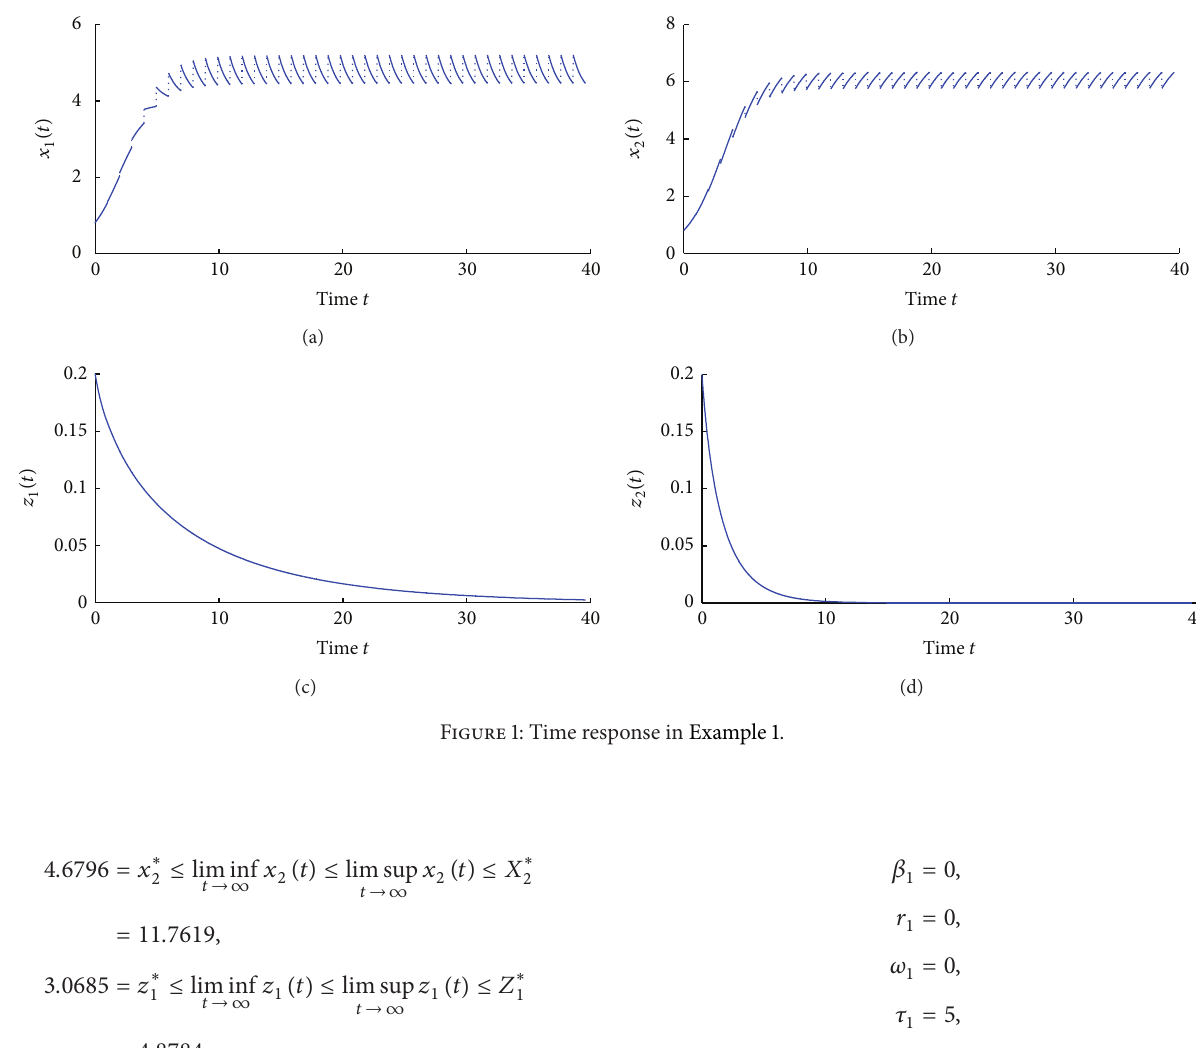
Figure 1: Time response in Example